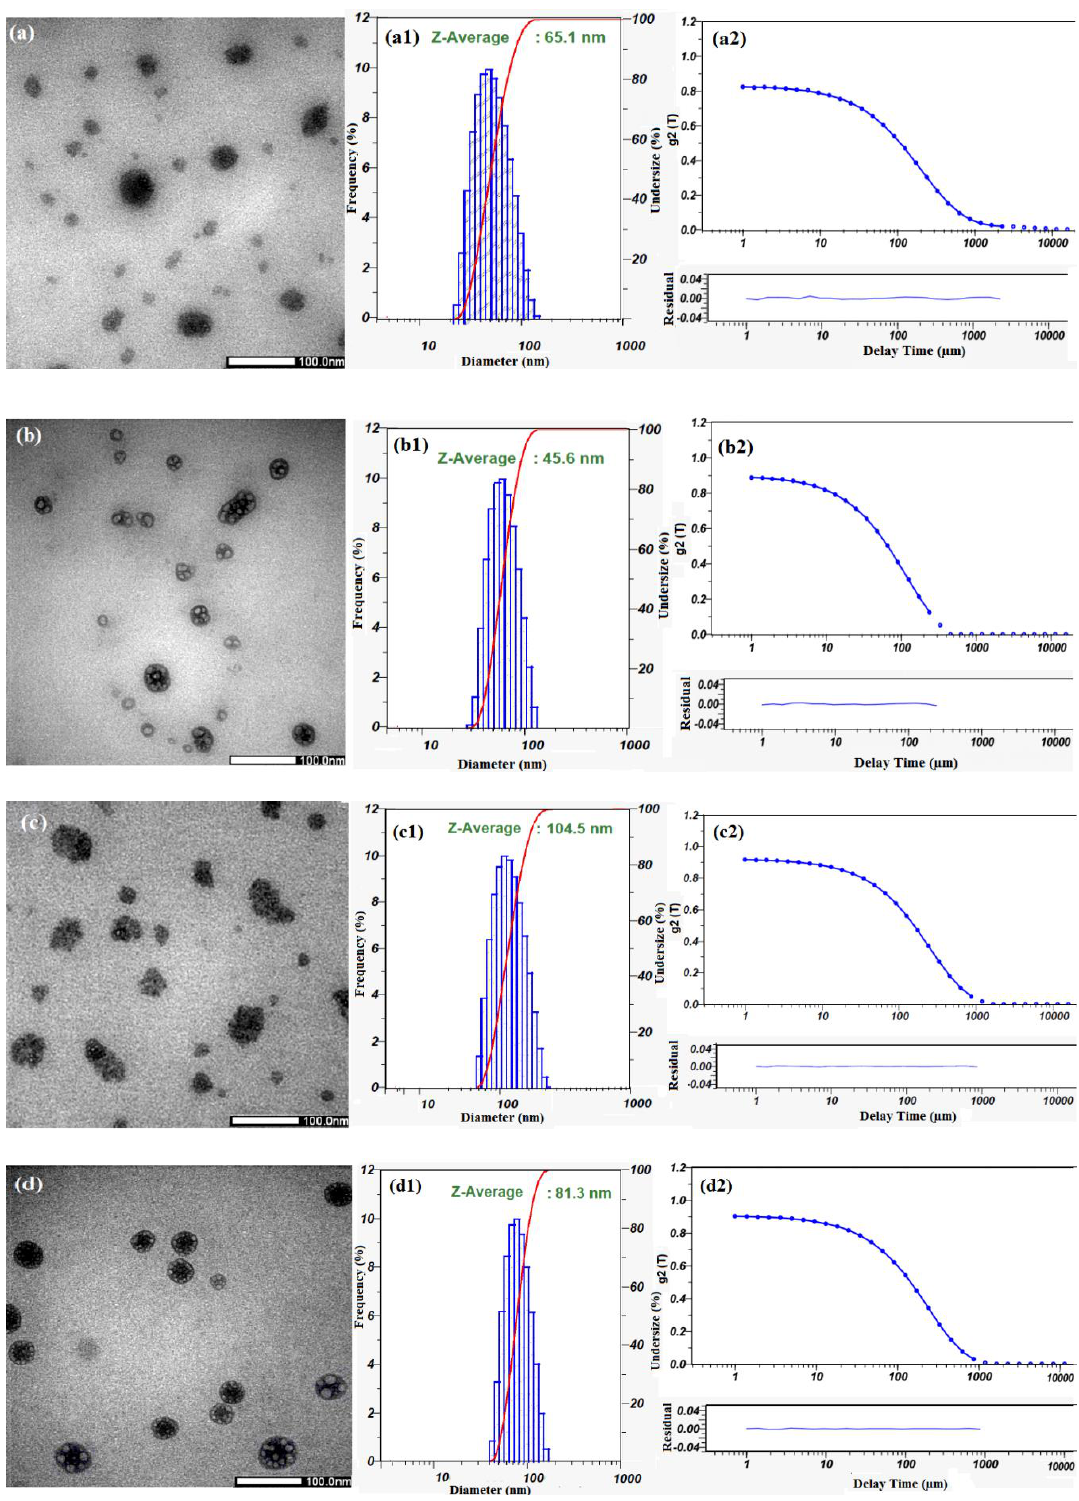
Figure 6. TEM images of pluronic and GP copolymers encapsulated (or dispersed) nCur: ( a ) pluronic F87, ( b ) pluronic F127, ( c ) GP-F87 and ( d ) GP-F127. F87, ( b ) pluronic F127, ( c ) GP-F87 and ( d )